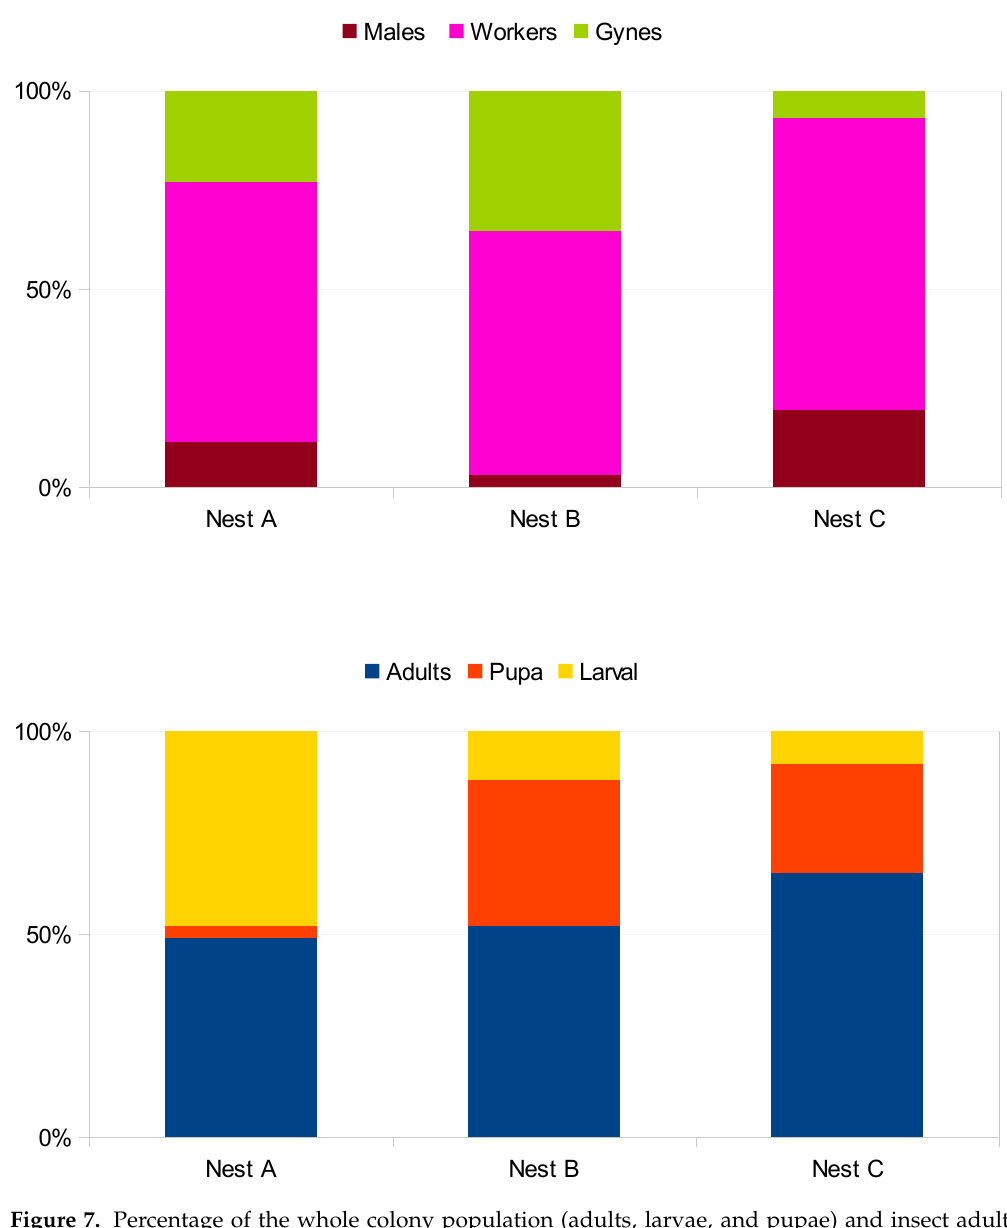
Figure 7. Percentage of the whole colony population (adults, larvae, and pupae) and insect adult population (males, workers, and gynes) of the V. velutina nests studied.